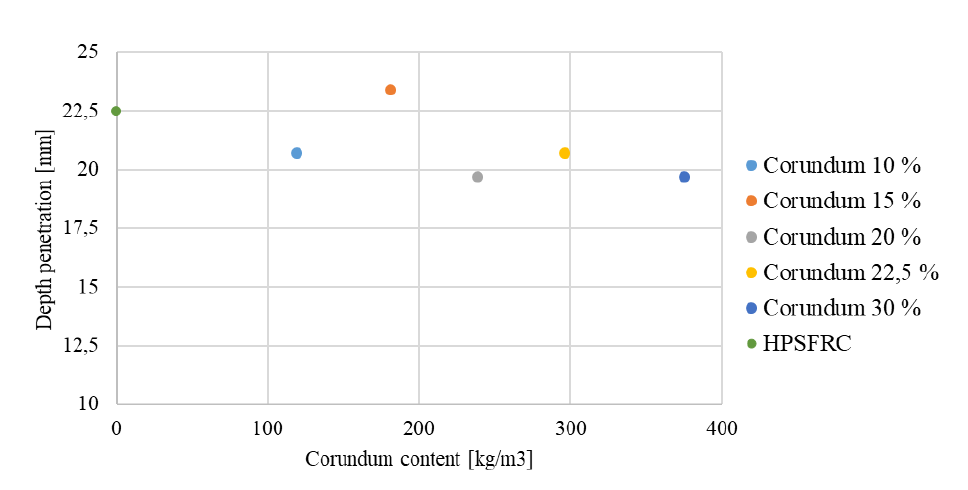
Figure 5. Dependence of depth penetration on corundum content.